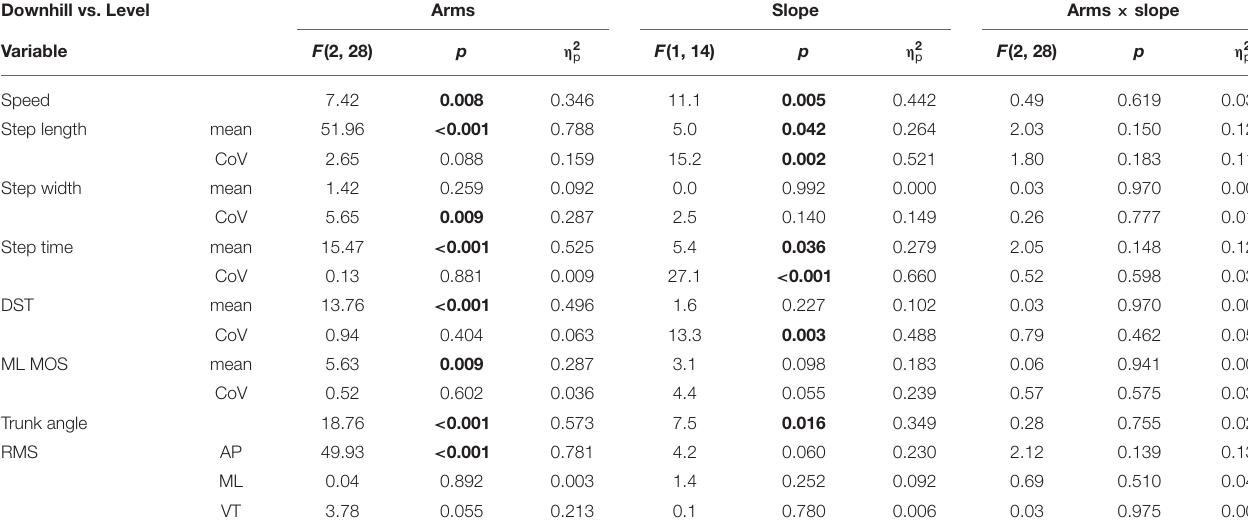
TABLE 2 | Main effects for uphill vs. level walking. Downhill vs.